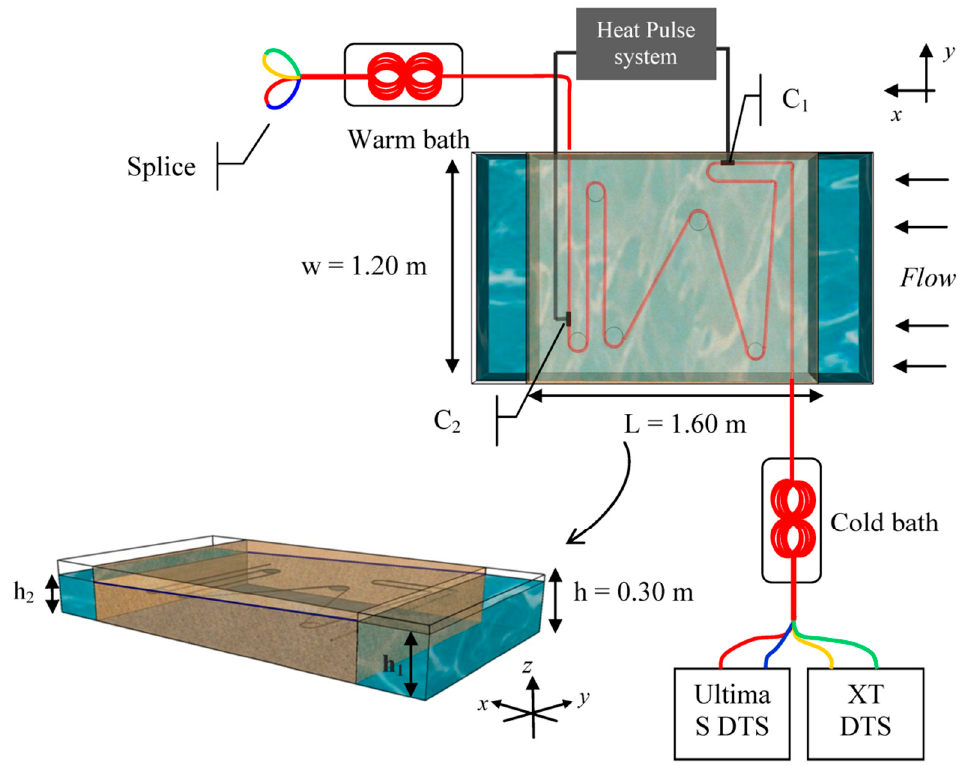
Figure 2. Experimental setup for Distributed Temperature Sending (DTS) measurements showing the dimensions of the sandbox and the deployment of fiber-optic cable (top view (x,y plane) and side view (x,y,z plane)). Each paired fiber was respectively connected to a Silixa Ultima S DTS unit and to a Silixa XT-DTS unit. The marks C 1 and C 2 represent connection points between fiber-optic cable and electrical cables allowing the injection of electricity into the steel frame of the cable.